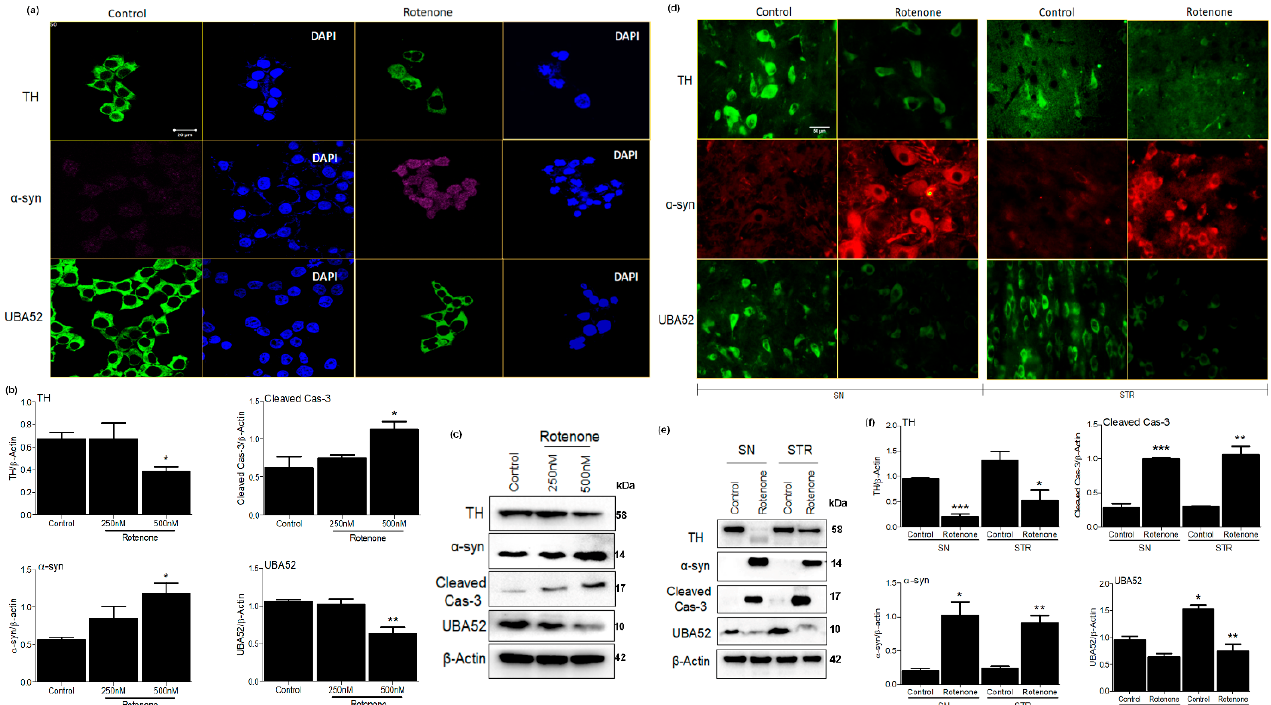
Figure 1. Parkinson’s disease markers and UBA52 expression in SHSY5Y and rat brain. ( a ) Confocal microscopy images depicting expression of TH, α -syn and UBA52 after secondary labeling with Alexa fluor -488 (green) and -546 (red), -647 (pink) in control vs. rotenone treated SH-SY5Y cells; n = 3. ( b , c ) A graphical and pictorial illustration of Western blot performed to assess the expression of TH, α -syn, cleaved cas-3 and UBA52, normalized against β -Actin in human SH-SY5Y neuroblastoma cells; n = 3. ( d ) Florescent images depicting the expression of TH, α -syn and UBA52 after secondary labeling with Alexa fluor -488 (green) and -546 (red) in control vs. rotenone treated SH-SY5Y cells, scale bar: 50 μ m; n = 3. ( e ) Immunoblot images illustrate the protein level of TH, α -syn, cleaved cas-3 and UBA52, normalized against β -Actin in rat brain regions. ( f ) Graphical representations of Western blot images normalized against β -Actin in SN and STR rat brain regions indicate a similar pattern as observed in SHSY5Y cells; n = 3. Quantifications are the mean and SEM of at least three independent experiments, and statistical analyses were performed using Student’s t -test and one-way ANOVA. * p < 0.05, ** p < 0.01, *** p < 0.001 control vs. Rotenone; # p < 0.05 R250nM vs. R500nM.